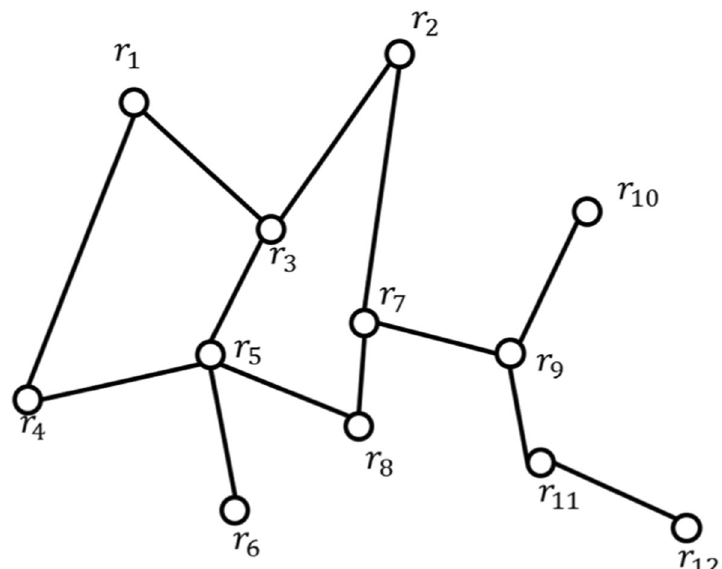
Fig. 3 An example of graph structure characterized by nodes and edges ( r i is the averaged independent pathway numbers defined in Eq.